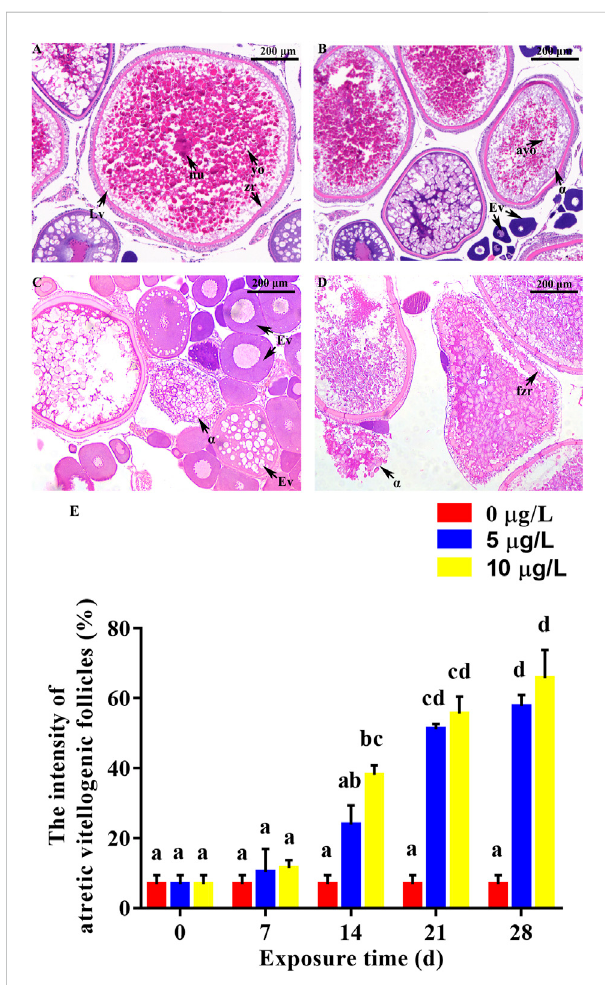
FIGURE 5 Effect ofCdexposureonovarytissueinfemalerareminnows. (A) Normal ovary (exposed to 0 μ g/L Cd). (B – D) Ovary of Cd exposure groups (exposed to 5 or 10 μ g/L Cd). (E) Intensities of atretic vitellogenic follicles of female rare minnows ( Gobiocypris rarus ). Bar with different letters between the control and exposed groups in the same day indicates statistically signi fi cant differences ( p < 0.05). Lv = oocyte at late vitellogenesis; Ev = oocyte at early vitellogenesis; α = α atretic vitellogenic follicles; yo = yolk granule; nu = nucleus; zr = zona radiata; ayo = absorbed yolk granule; fzr = fragmented zona radiata. α atretic vitellogenic follicle presented in the sections, characterized by absorption of the yolk granule and fragmentation of the zona radiata.